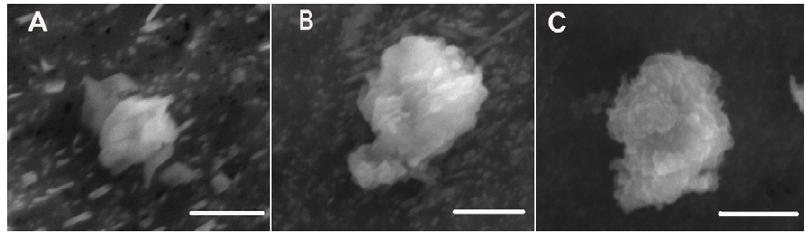
Figure 2. ESEM images of EPS microgel. (A) Amphora sp. (Scale Bar=4 m m) (B) Ankistrodesmus angustus (Scale Bar=5 m m) (C) Phaeodactylum tricornutum (Scale Bar=5 m